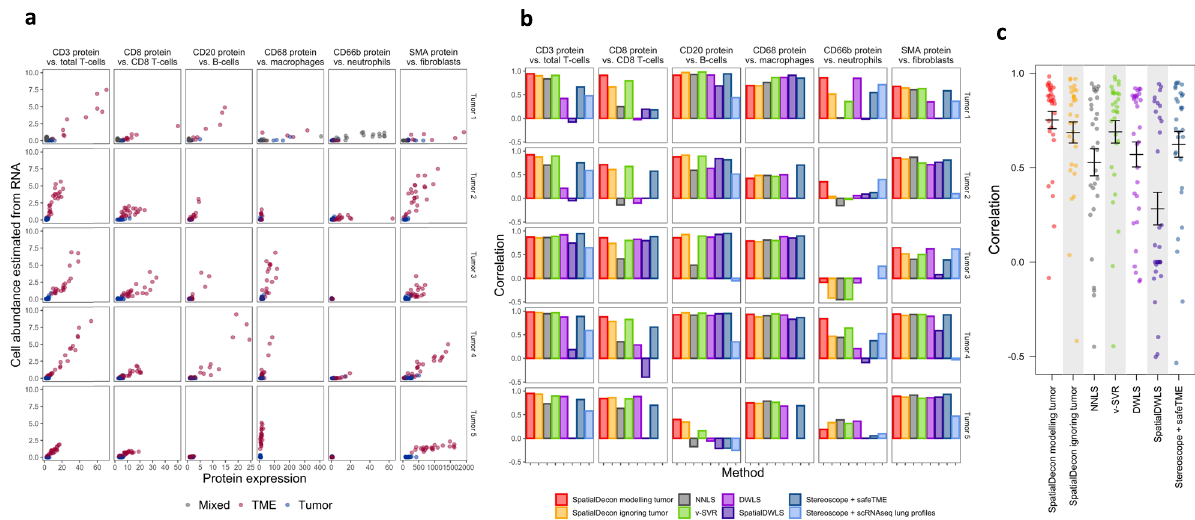
Fig. 4 Benchmarking of immune deconvolution against the expression of canonical marker proteins. a Expression of marker proteins (horizontal axis) against cell abundance estimates from the application of SpatialDecon to gene expression data (vertical axis). Each column of panels shows results from a single protein/cell pair; each row shows results from a different lung tumor. Tumor segments are shown in blue, microenvironment segments in red. b Pearson correlation between protein and cell abundance estimates for different deconvolution algorithms. NNLS non-negative least squares, v-SVR v-support vector regression, DWLS Dampened Weighted Least Squares. CD8 T cells and macrophages are unavailable under the Stereoscope + scRNA- seq lung pro fi les method. c Mean correlations between deconvolution methods and protein expression. Lines show 95% con fi dence intervals from n = 30 correlations. Source data are provided as a Source Data fi